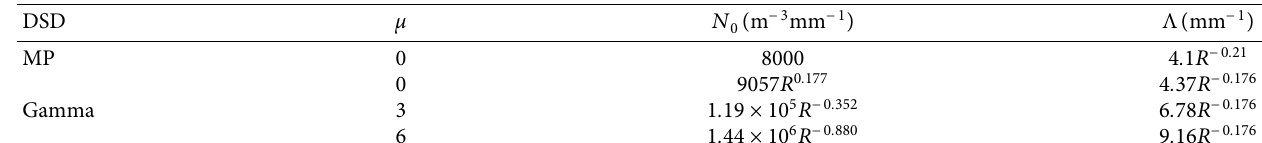
Table 3: DSD parameter [20].